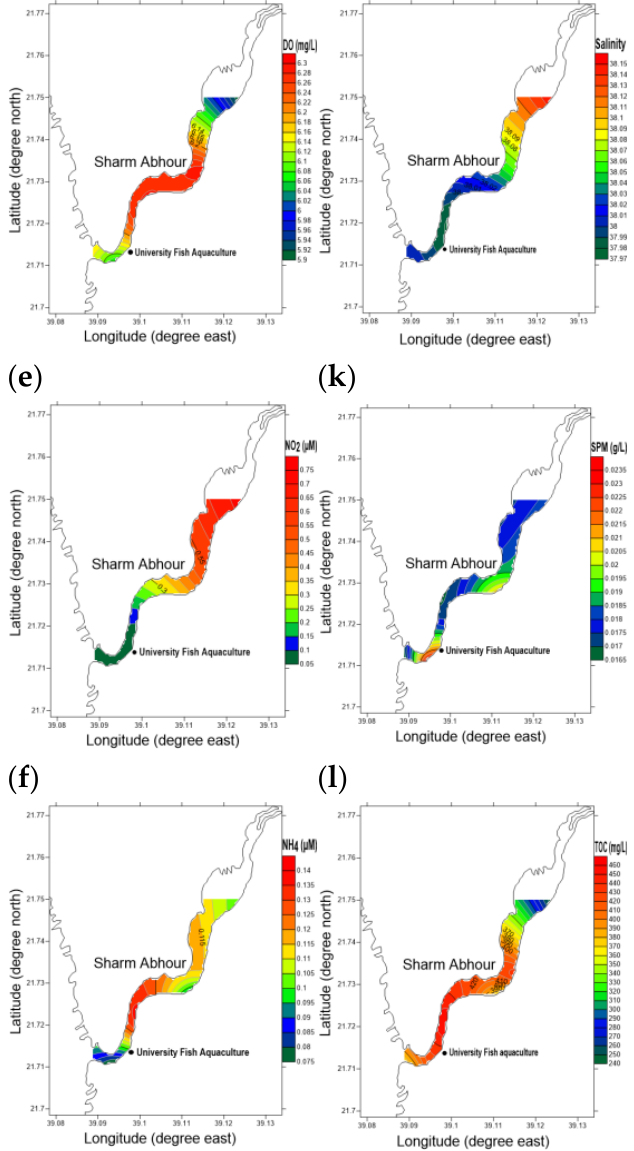
Figure 9. Physical and chemical parameters horizontal distribution along the Sharm Obhur surface water. Table 6. Nutrient correlation coefficient against salinity in the surface and bottom water of Sharm Obhur (n = 6 stations).